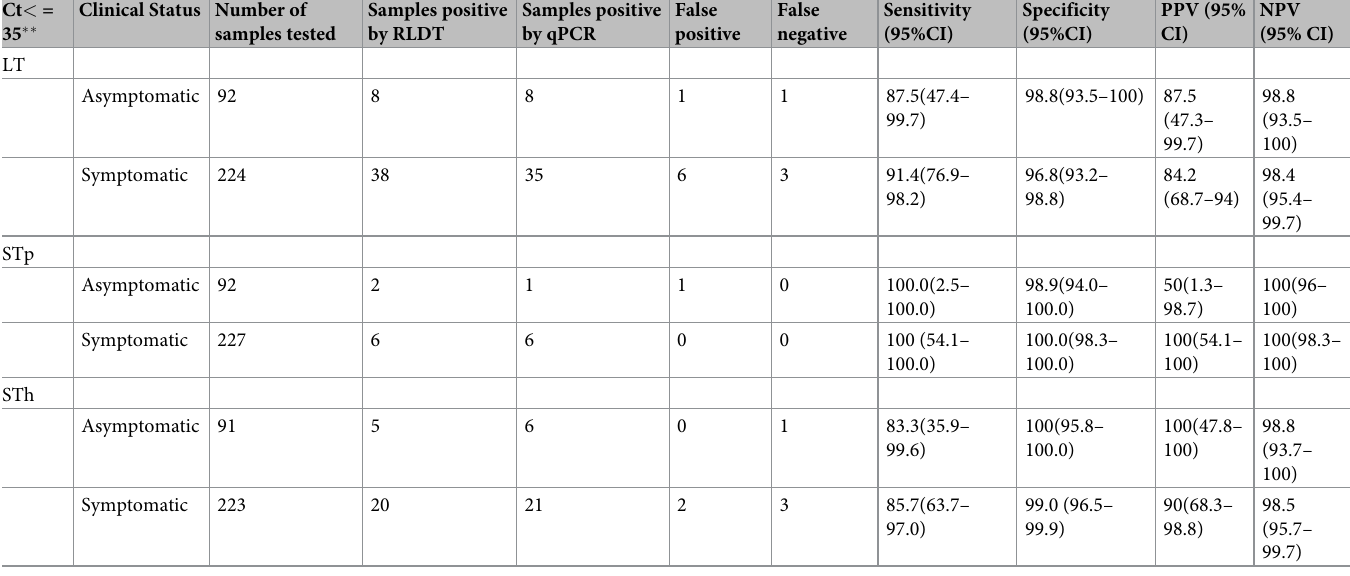
Table 3. Performance of RLDT against qPCR by the clinical state of participants. Ct < = Clinical Status Number of Samples positive 35 �� samples tested by